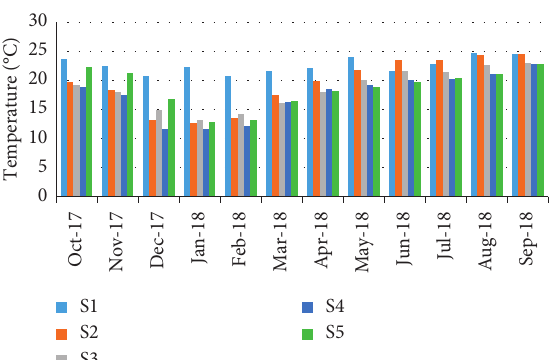
Figure 6: Spatial-temporal variation of dissolved oxygen in the Zegzel